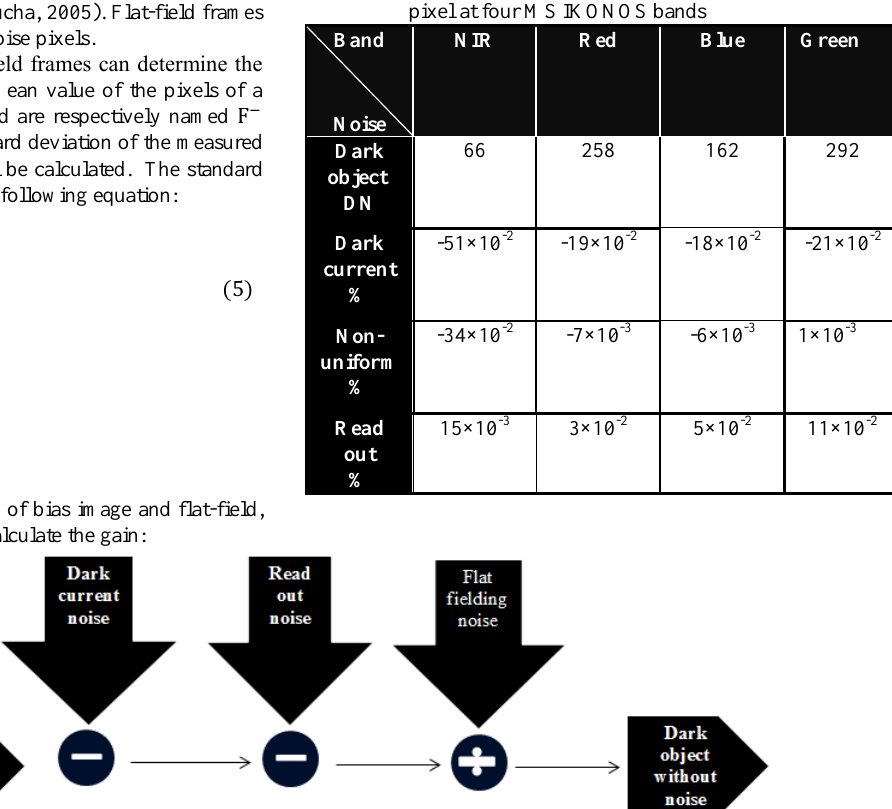
Table 2. The percent of electronic noise from dark objective